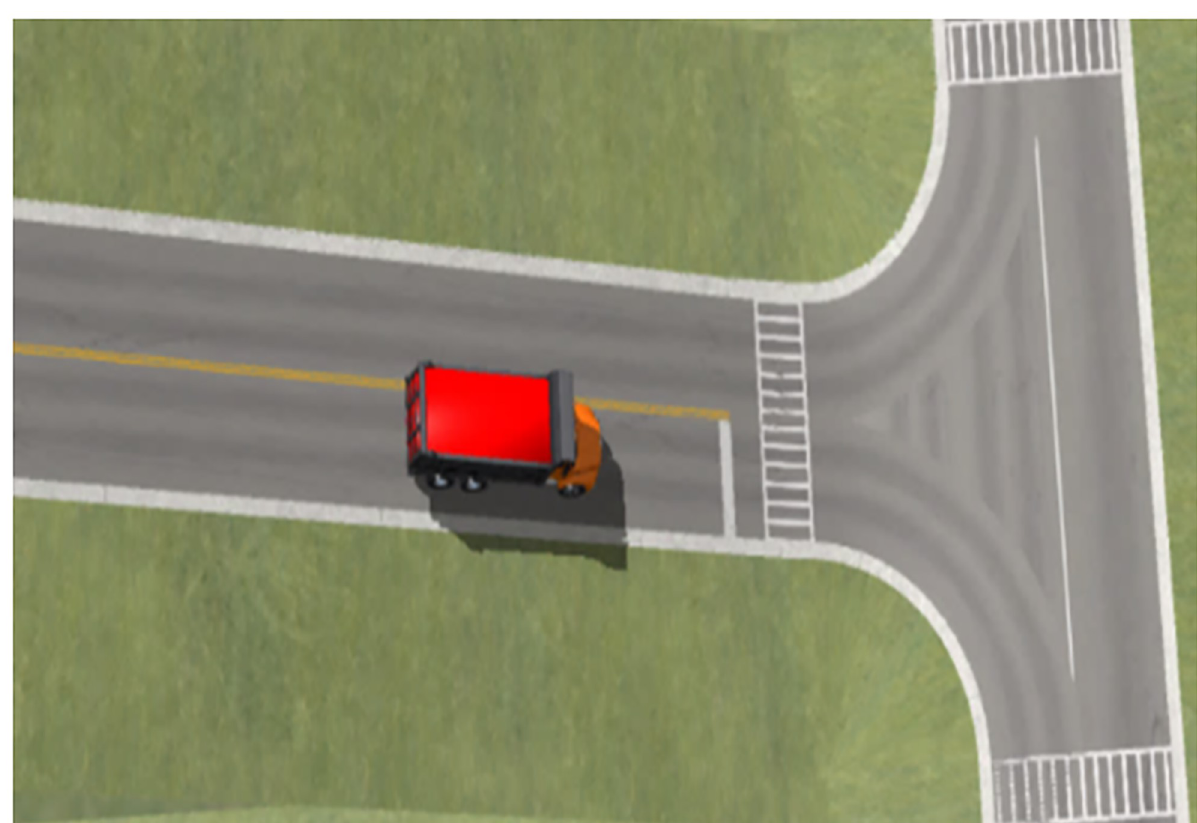
Fig 3. Simulation model of typical scene of right turn at a long downhill T-junction.